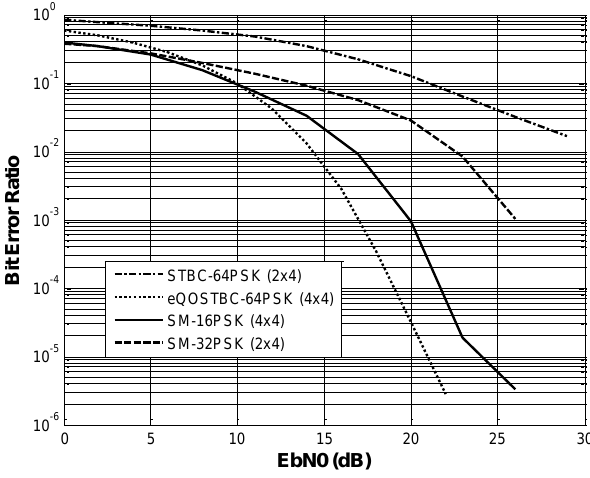
Figure 11: Comparison of six bits transmissions using SM, STBC and QOSTBC